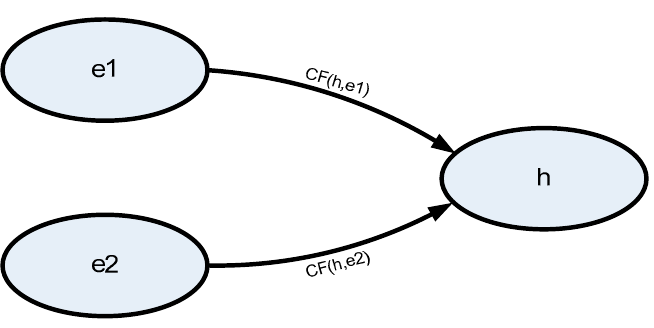
Figure 7. Parallel passages between two observations and the hypothesis.